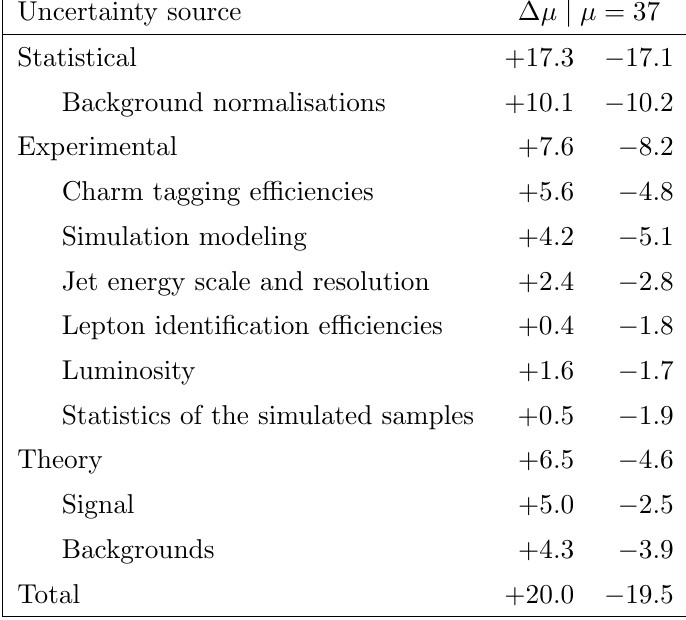
SM production of VH(H ! cc) is extracted at 95% CL based on a modi(cid:12)ed frequentist approach [96, 97] under the asymptotic approximation for the pro(cid:12)le likelihood test